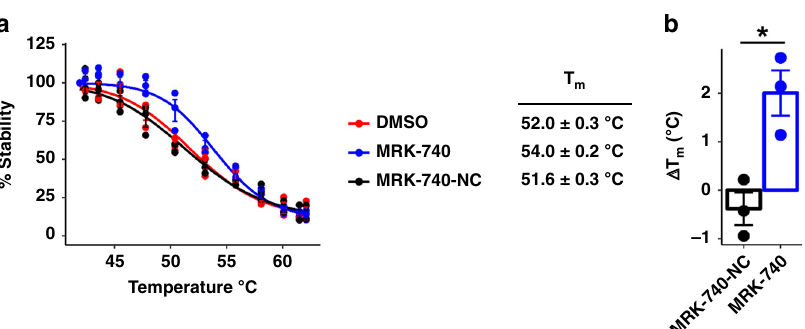
Fig. 5 MRK-740 engages PRMD9 in a cell-based thermal stability assay. a Effect of MRK-740 (10 µ M) or MRK-740-NC control compound (10 µ M) on the thermal stability of NanoLuc-tagged PRDM9 (residues 135 – 285) in cells. Shown is the mean ± SEM of three biological replicates. b T m -shift ( Δ T m ) of NanoLuc-tagged PRDM9 in response to MRK-740 (10 µ M) or MRK-740-NC control compound (10 µ M). Shown is the mean ± SEM of three biological replicates. Boxes indicate the mean values. P -values calculated using an unpaired Welch ’ s two-tailed t -test, * p -value = 0.017. Source data are provided as